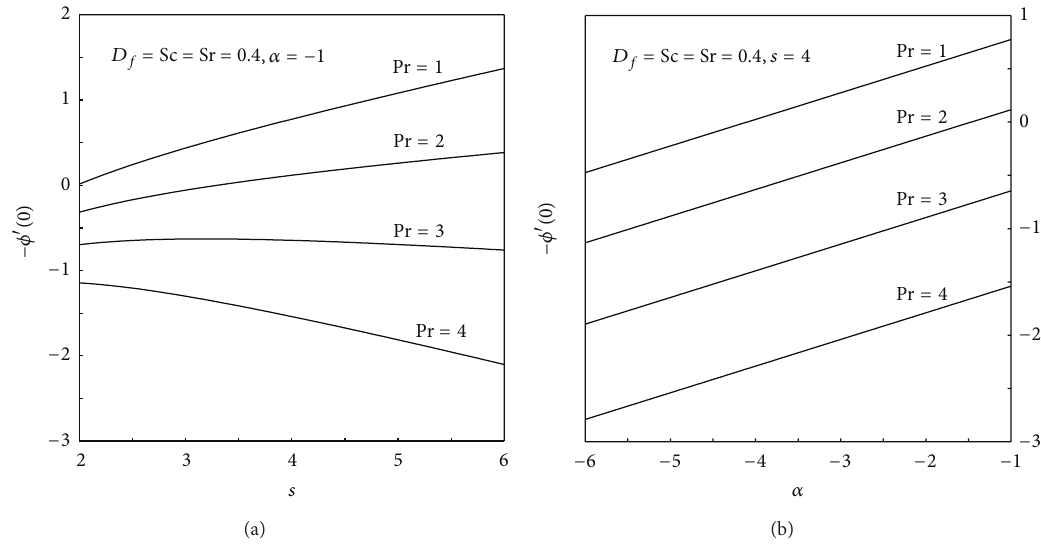
Figure 7: (a) Wall mass flux, −𝜙 󸀠 (0) with 𝑠 for various values of Pr. (b) Wall mass flux, −𝜙 󸀠 (0) with 𝛼 for various values of Pr.